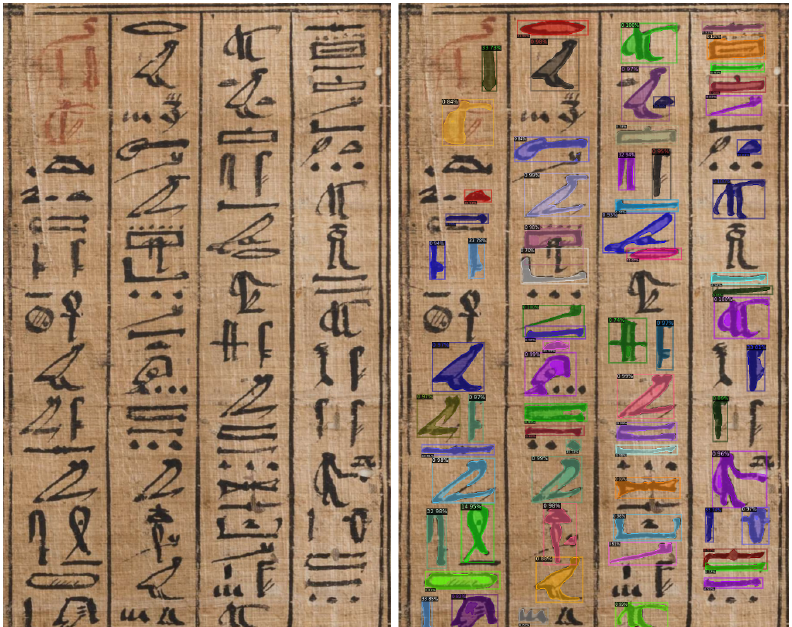
Figure 9. Segmentation example on Cyperus papyrus. From the Book of the Dead of Nebhepet, scribe of the necropolis (cat. number 1768). Credit to the Egyptian Museum of Turin online collection